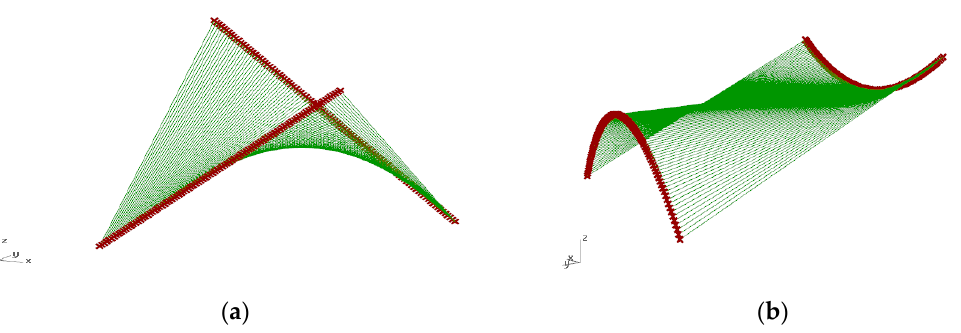
Figure 2. The base surfaces for bar grids of: ( a ) hyperbolic paraboloid shape; ( b ) cylindroid shape. The surfaces have been defined parametrically by means of Grasshopper’s block scripts, presented in Figure 3, and have been established by the following procedure: each directrix line was divided into the same number of parts; next, each surface ruler was defined by connecting two proper points that are included in various directrix lines. division into the same number of parts in both x and y directions. In this way, grid vertices